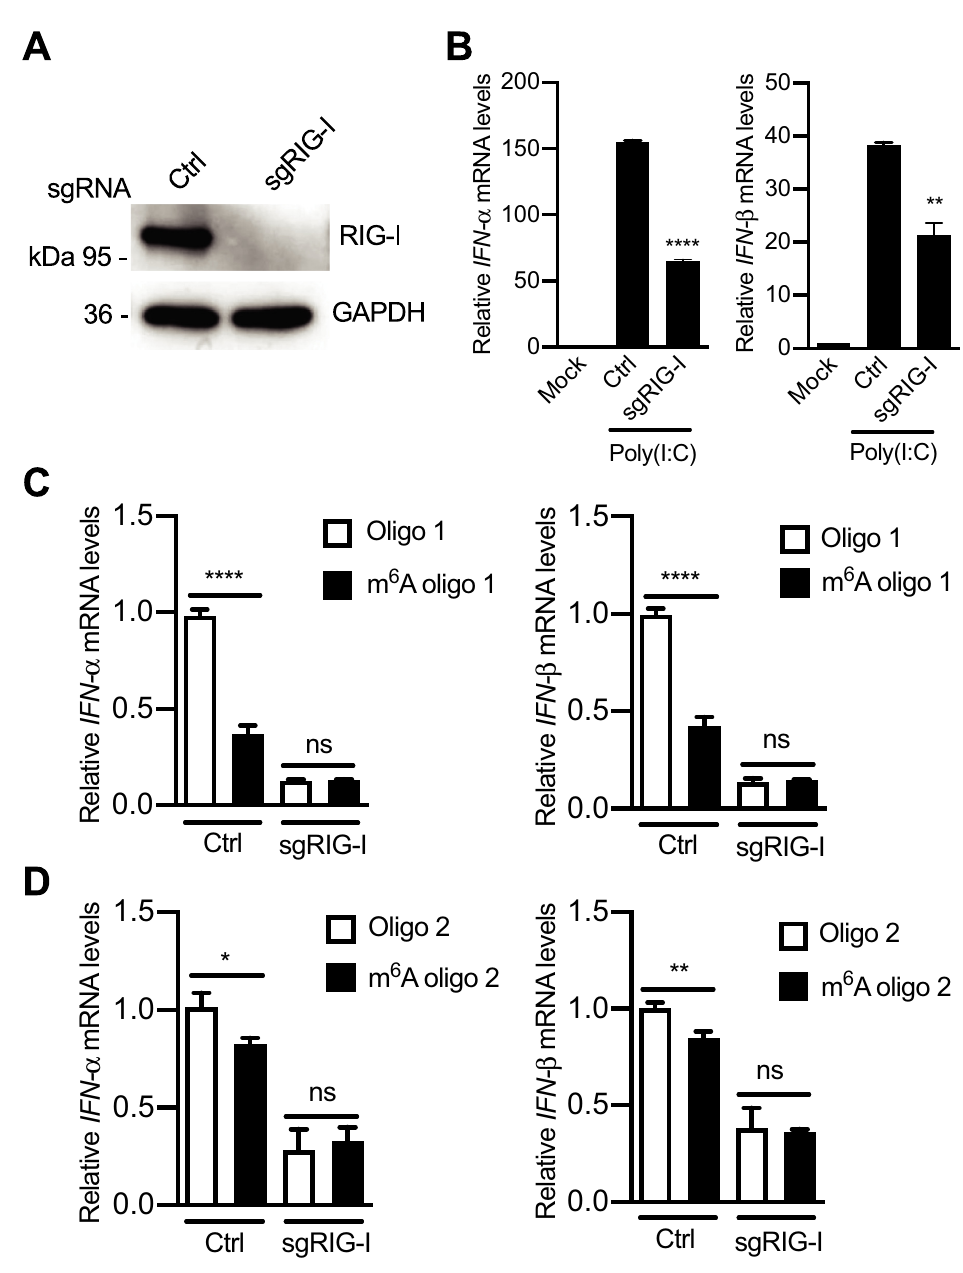
Fig 10. RIG-I senses m 6 A modification of HIV-1 RNA to induce IFN-I expression. (A) RIG-I expression levels in control (Ctrl) and RIG-I knockout (sgRIG-I) U937 cells were measured by Western blotting. (B) Ctrl and RIG-I KO U937 cells were transfected with 250 ng of poly(I:C). At 16 hr post-transfection, cells were collected for the analysis of IFN- α and IFN- β mRNA levels by RT-qPCR. The results are shown as means ± S.D. of three repeats with similar results. �� P < 0.005, ���� P < 0.0001. (C and D) PMA-differentiated Ctrl and RIG-I KO U937 cells were transfected with 250 ng of HIV-1 RNA oligo 1 (C) or oligo 2 (D) . After 16 hr, cells were collected for the analysis of IFN- α and IFN- β mRNA levels by RT-qPCR. The results are shown as means ± S.D. of three repeated experiments. � P < 0.05, �� P < 0.005, ���� P < 0.0001. Un-paired t-test was used for statistical analysis. ns, not